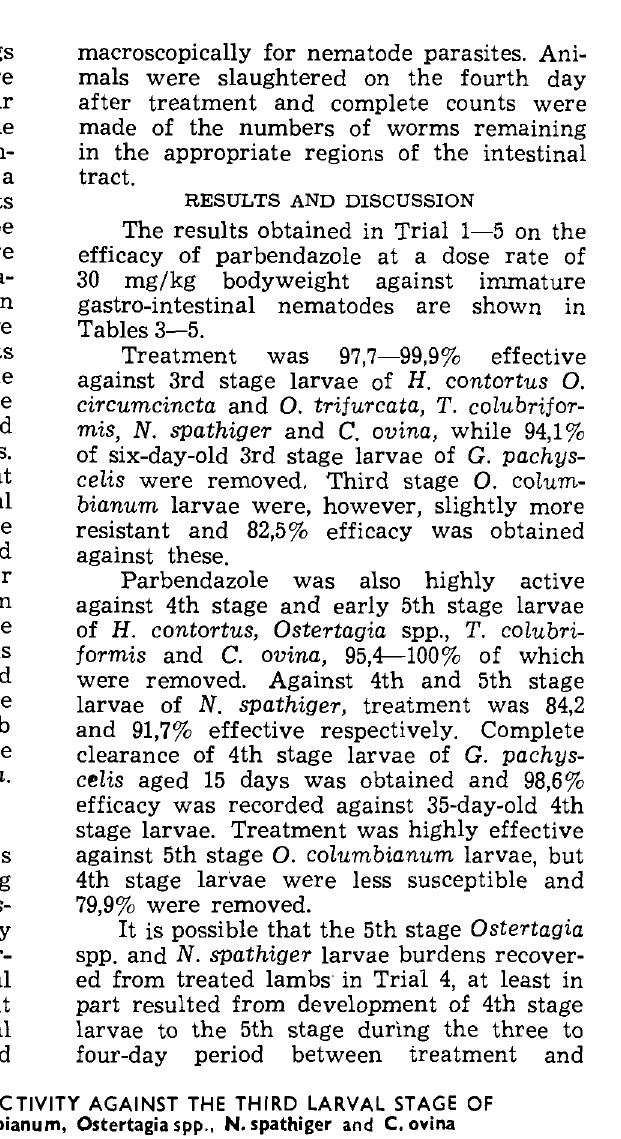
Table 3: TRIALS 1 AND 2- ANTHELMINTIC ACTIVITY AGAINST THE THIRD LARVAL STAGE OF H. contortus, T. colubriformis, O. columbianum, Ostertagia spp., N. spathiger and C.ovina NUMBERS OF WORMS RECOVERED AT AUTOPSY Trial I Species Control No.